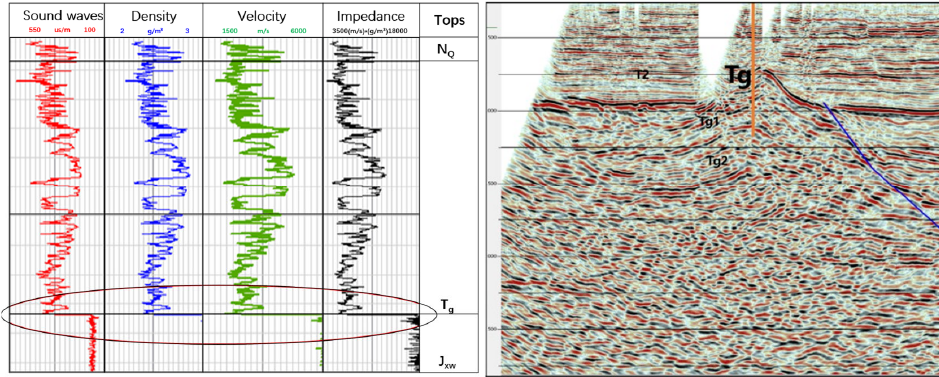
Figure 2. Composite logs of a sedimentary hydrothermal well and the seismic profile over it.